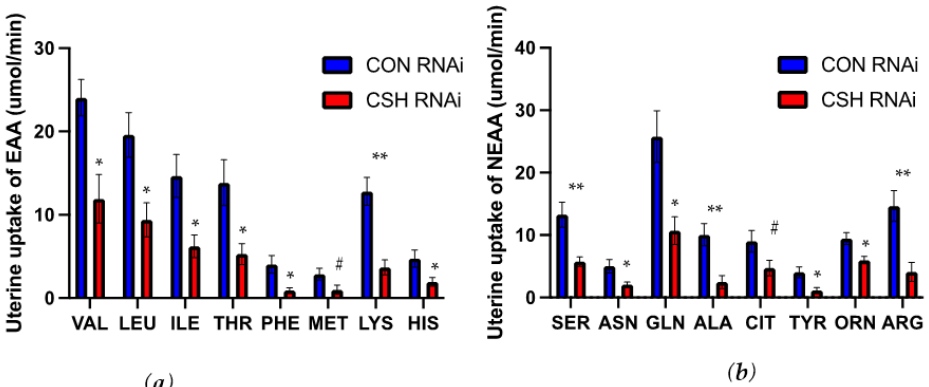
Figure 5. Uterine uptakes of essential (EAA) and nonessential (NEAA) assessed by 3 H 2 0 transplacental diffusion at 130 dGA: ( a ) uterine uptakes of essential amino acids, µmol/min ( b ) uterine uptakes of essential amino acids, µmol/min. Data are shown as means ± SEM for all pregnancies in each treatment group. CSH, chorionic somatomammotropin; RNAi, RNA interference. Ala, alanine; Arg, arginine; Asn, asparagine; Cit, citrulline; Gln, glutamine; His, histidine; Ile, isoleucine; Leu, leucine; Lys, lysine; Met, methionine; Orn, ornithine; Phe, phenylalanine; Ser, serine; Thr, threonine; Tyr, tyrosine; Val, valine. ** p ≤ 0.01, * p ≤ 0.05, # p ≤ 0.10, when CSH RNAi pregnancies are compared with control RNAi pregnancies.